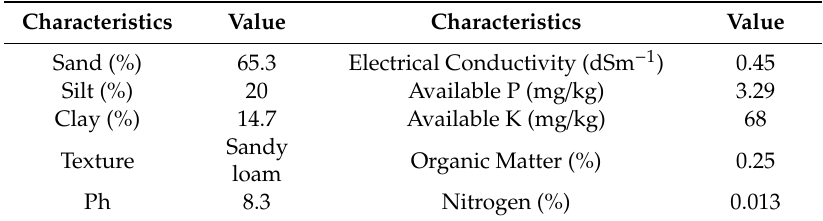
Table 7. Pre-sowing analysis of soil used in the glass house